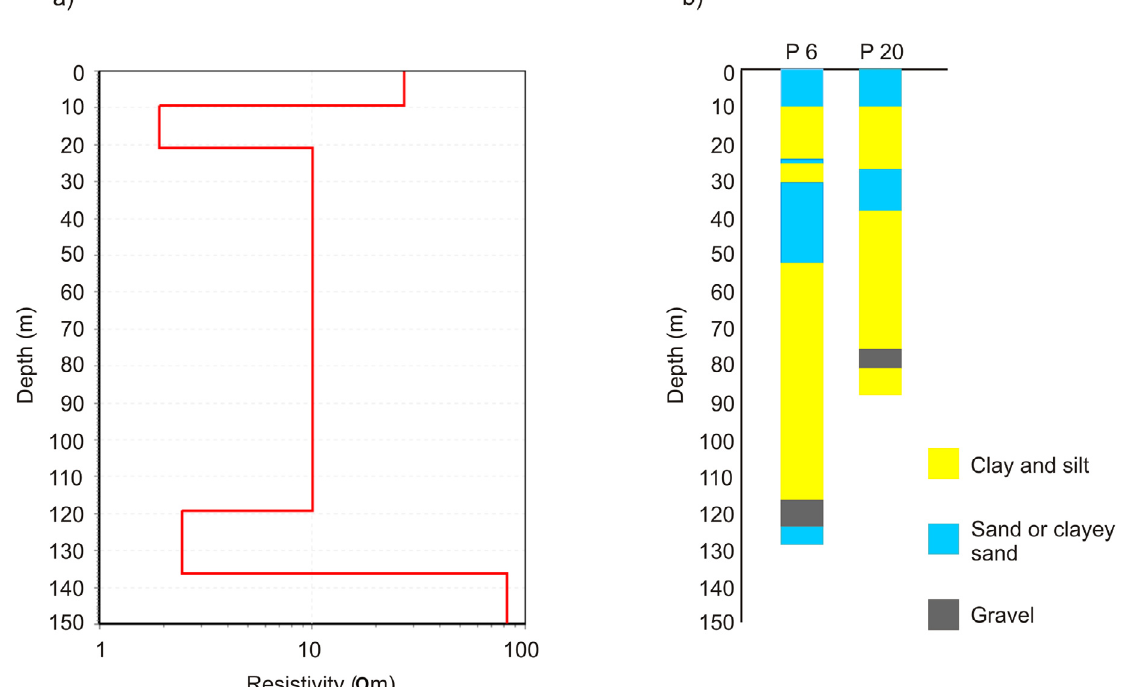
Figure 8. (a) 1-D reference resistivity model of the Italian reference site. Data inversion recovered a 5 layers resistivity model which provides us the best fit of the observed data. (b) Simplified representation of the boreholes stratigraphy (adapted from Butteri et al.